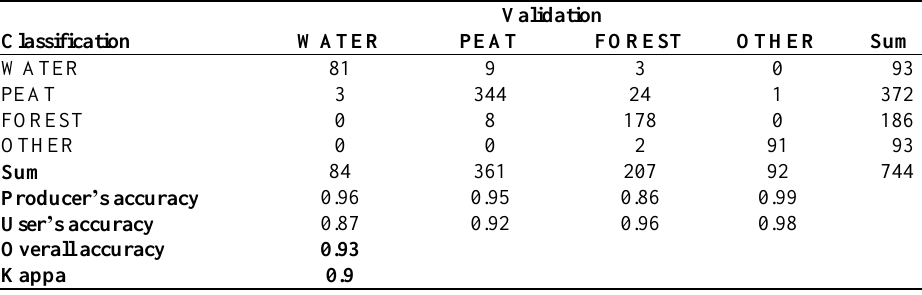
Table 4. Confusion matrix for 9 June 2010 image coarse-scale classification (Step 2), considering the environmental groups of the validation